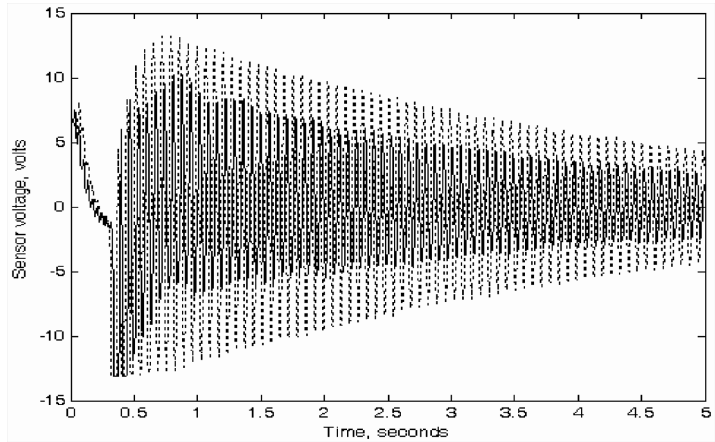
Fig. 16. Response of the plate when tip mass of 20 grams is placed on free edge and is controlled by SMC (with boundary